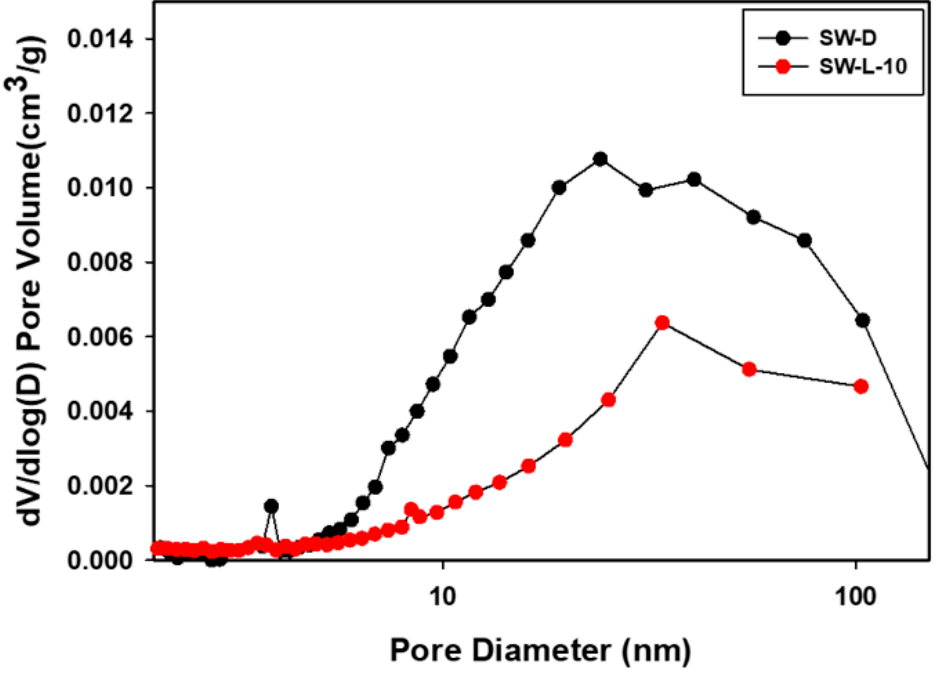
Figure 3. Pore diameter distributions of SW-D and SW-L-10. Table 2. Surface area and pore volume distribution (SW-D and SW-L-10).